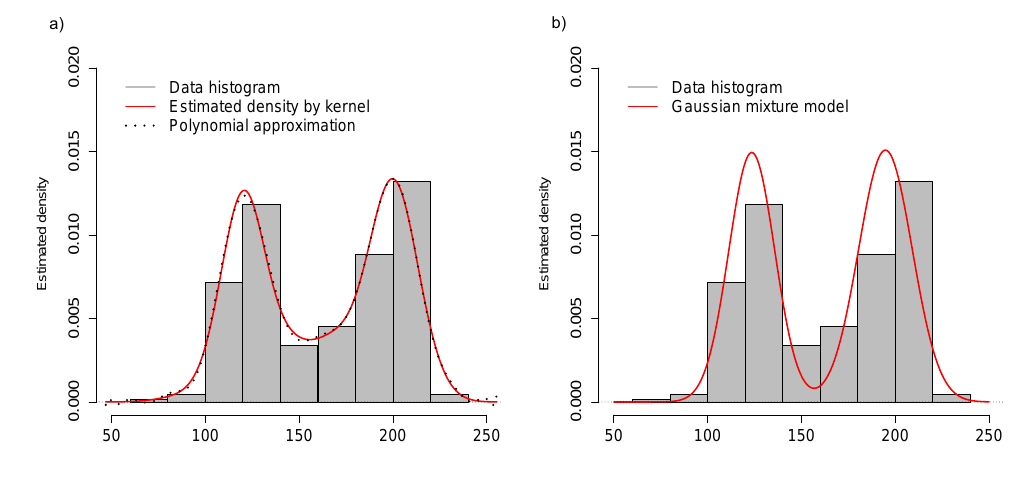
Figure 7. Density estimated by: ( a ) Kernel method. ( b ) Gaussian mixture model.